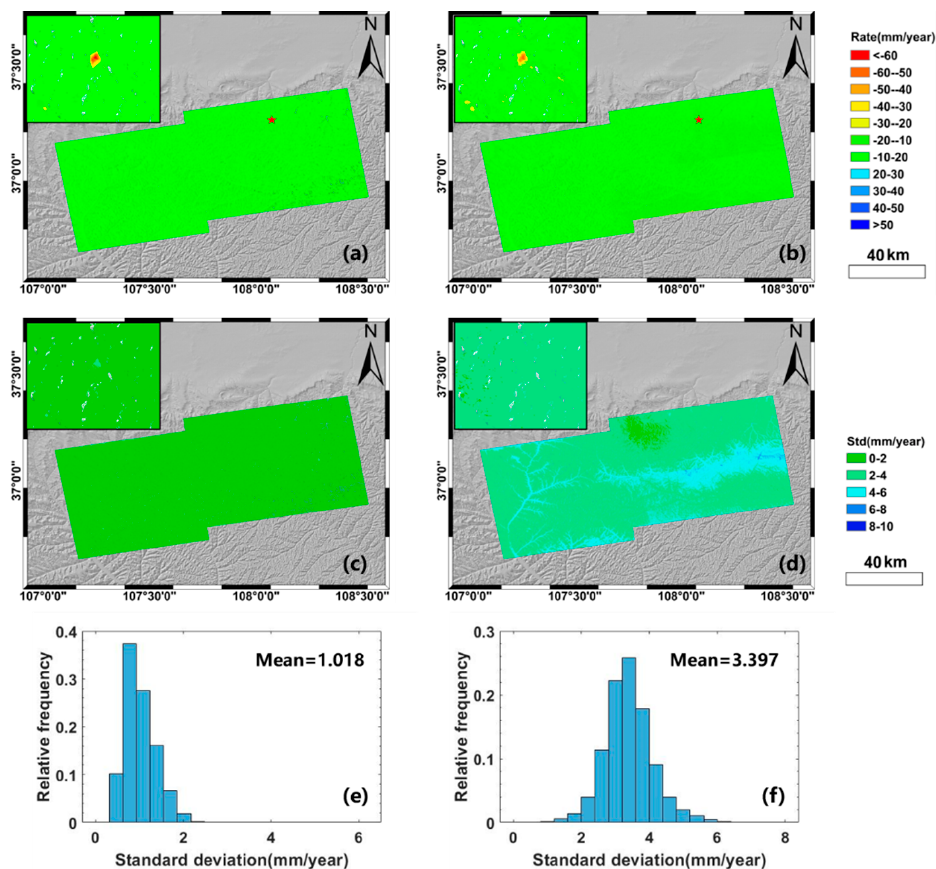
Figure A4. A comparative results of SAR datasets from frame 115 for deformation rate ( a , b ), standard deviation of the deformation rate ( c , d ) and histogram of the standard deviation ( e , f ) for two processing methodologies: QT − SP and LM − DT. The left column shows QT − SP results; the right column shows LM − DT results. Note that the results in both columns are based on the corresponding interferogram network selected by point P1 in Figure 4, and the red pentacle indicates the enlarged area.